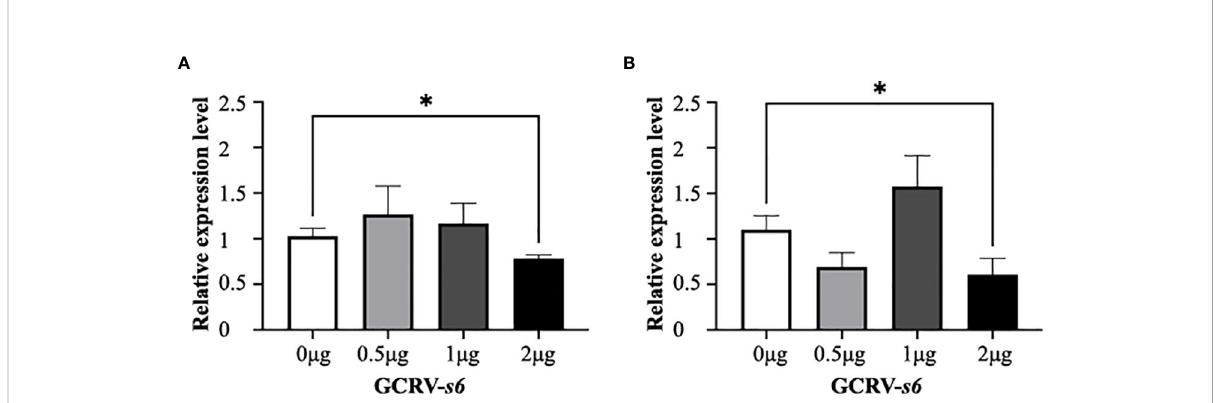
FIGURE 6 Expression changes of GCRV s6 detected at different time points after co-expression of serpina1 and cf2 . (A) Relative expression levels of GCRV s6 after 12 h of GCRV infection, when the transfection amount of serpina1 gradually increased. (B) Relative expression levels of GCRV s6 after 24 h of GCRV infection, when the transfection amount of serpina1 gradually increased. The GCRV s6 expression level, when transfected with 0 m g plasmid, was set as “ 1 ” as the control, and “ * ” indicates p <